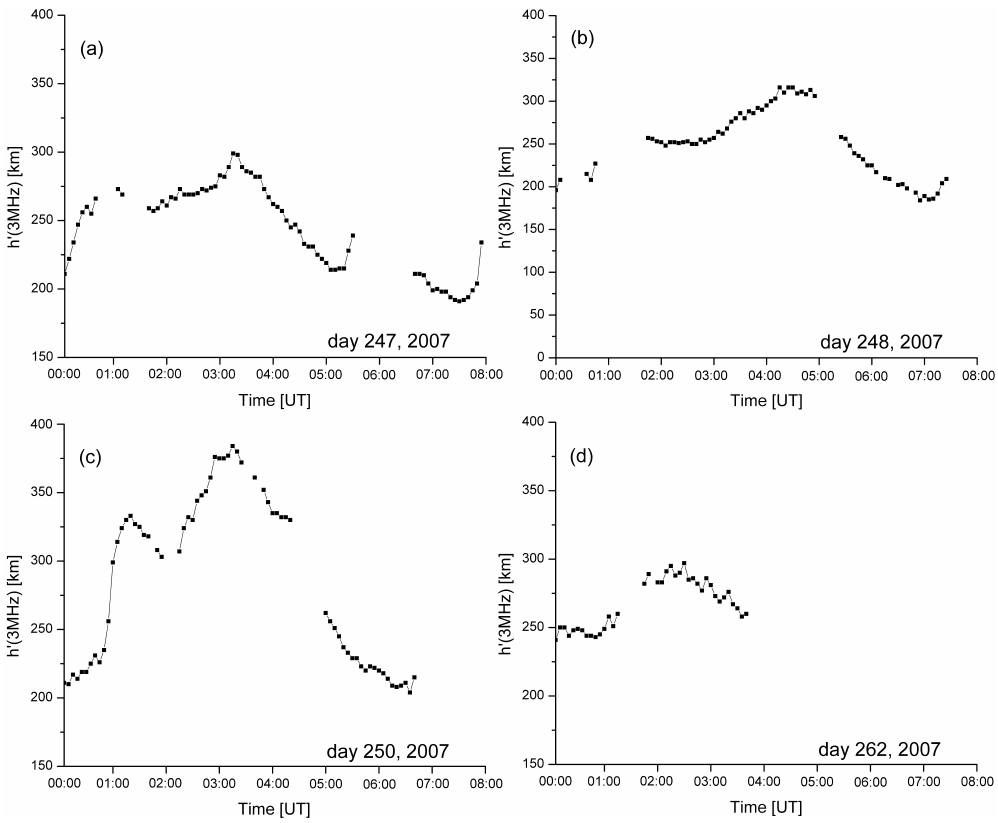
Fig. 2. Scaled virtual heights at 3MHz [ h 0 (3MHz)] for days 247, 248, and 262, 2007, with RSF, and day 250, 2007, without